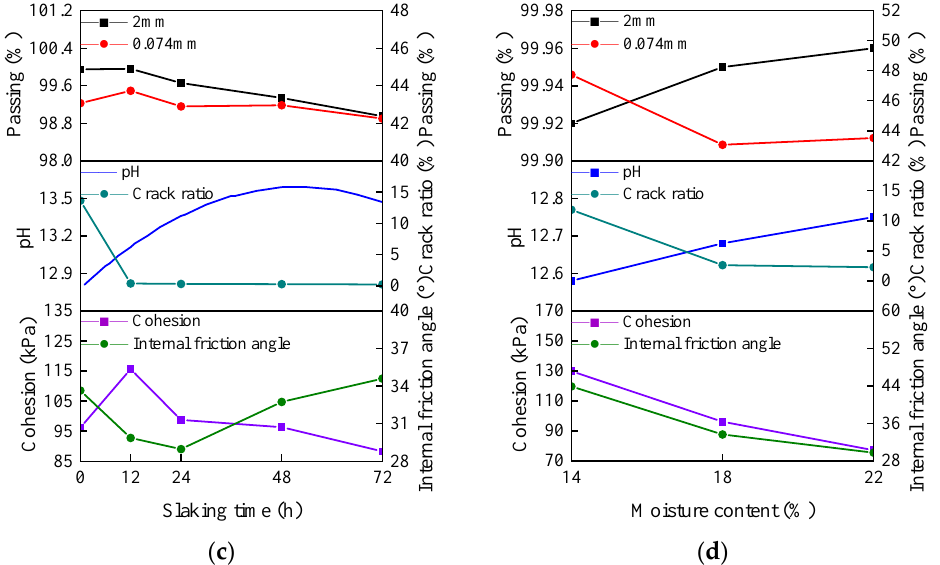
Figure 11. The relationship curve particle curve, pH value, crack ratio, cohesion and internal friction angle of specimen: ( a ) M = 10%, W = 18%; ( b ) M = 15%, W = 18%; ( c ) M = 20%, W = 18%; ( d ) T = 0 h, M = 20%.